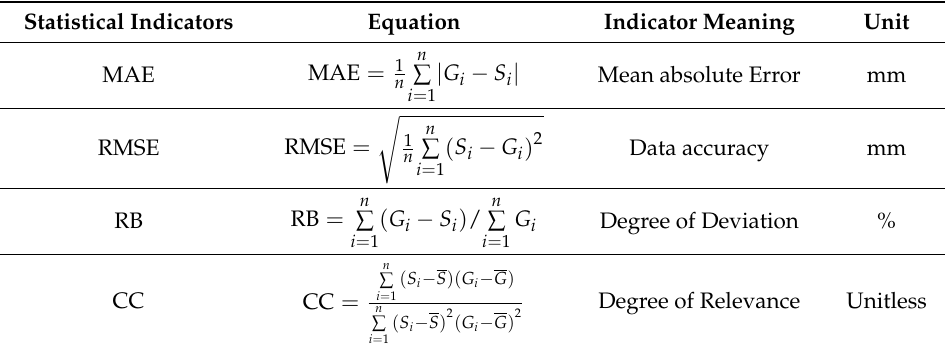
Table 3. Evaluation indicators of error